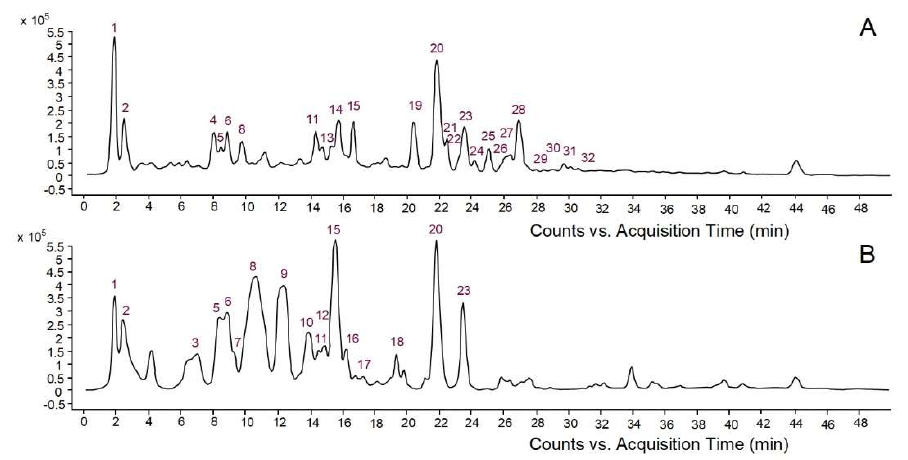
Figure 1. Base peak chromatograms of Picea abies ( A ) and Pinus nigra ( B ) aqueous bark extracts.